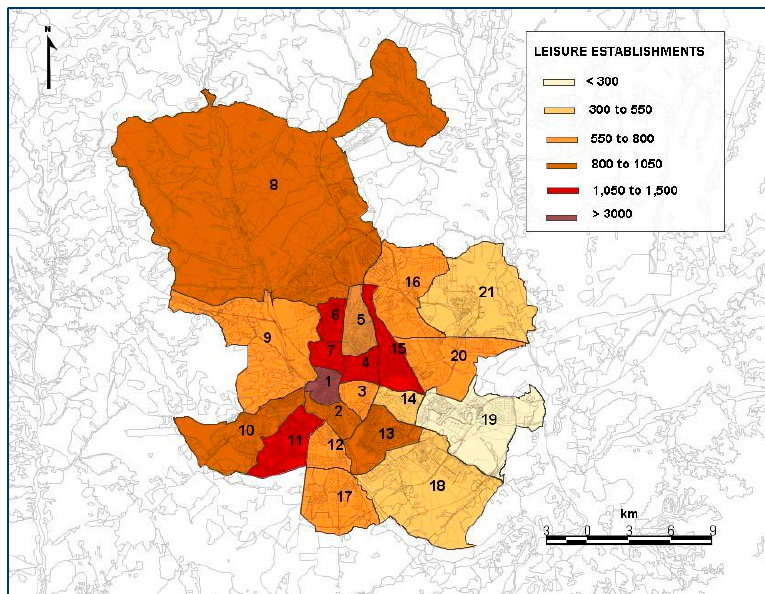
Figure 2. Average number of leisure establishments in the districts of Madrid analyzed in the period 2013–2019. Source: Own elaboration, based on the data drawn from the statistical information de-